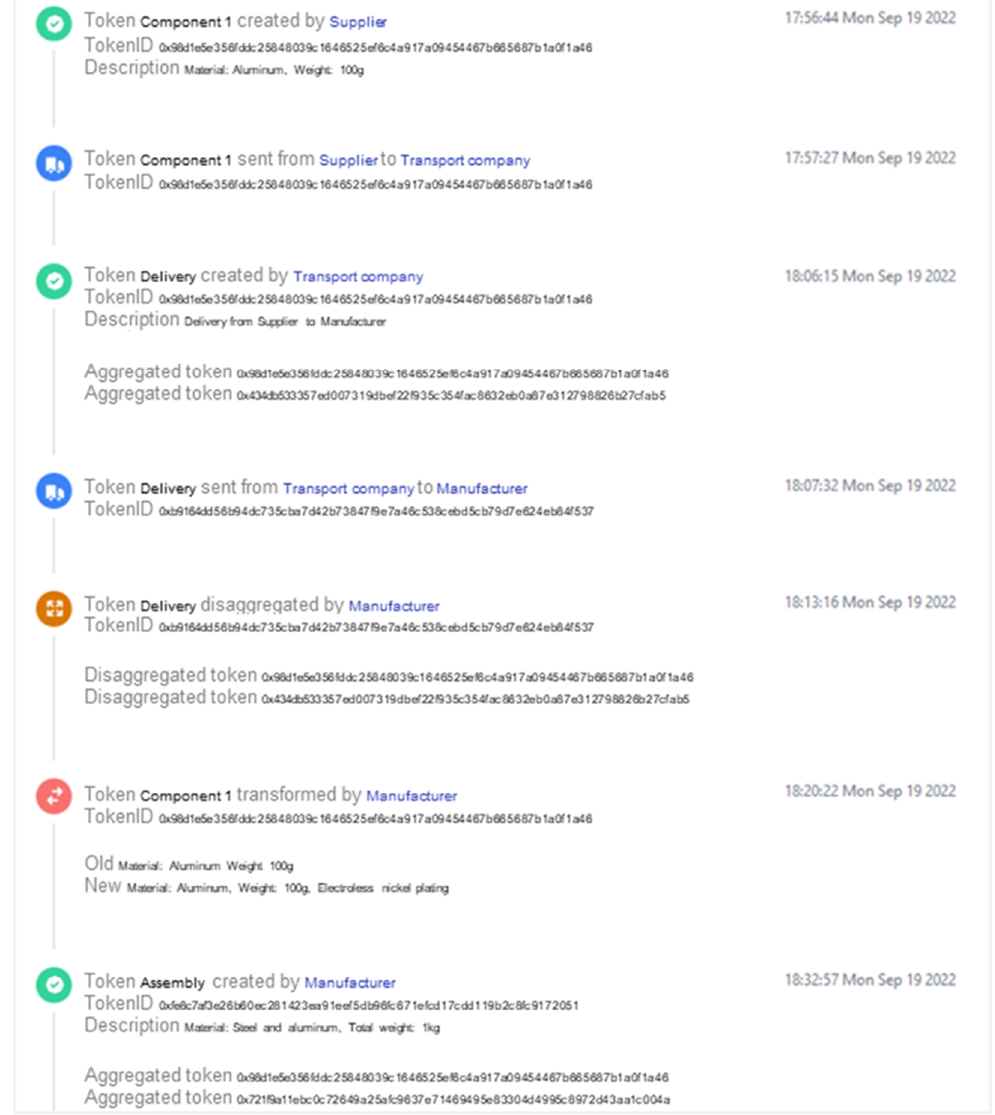
Figure 10. Interface for accessing the token history.